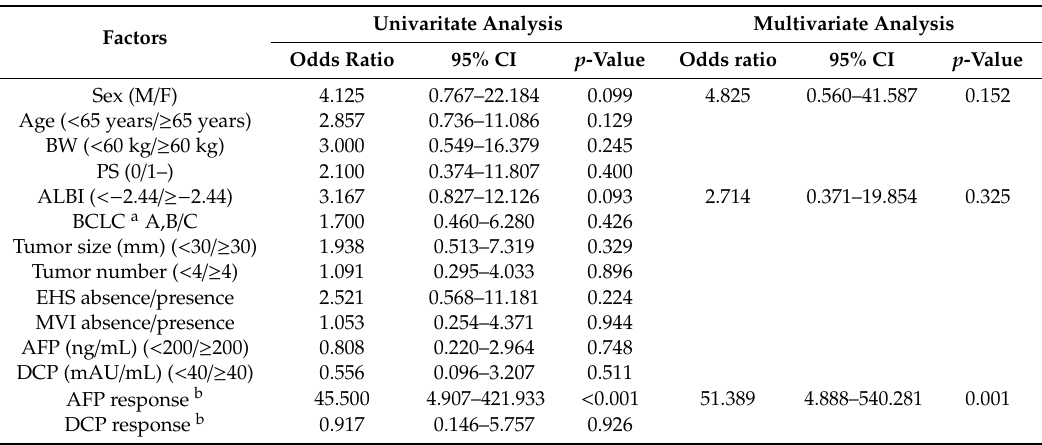
Univariate and multivariate analyses for factors a ff ecting objective response in the high-alpha-fetoprotein